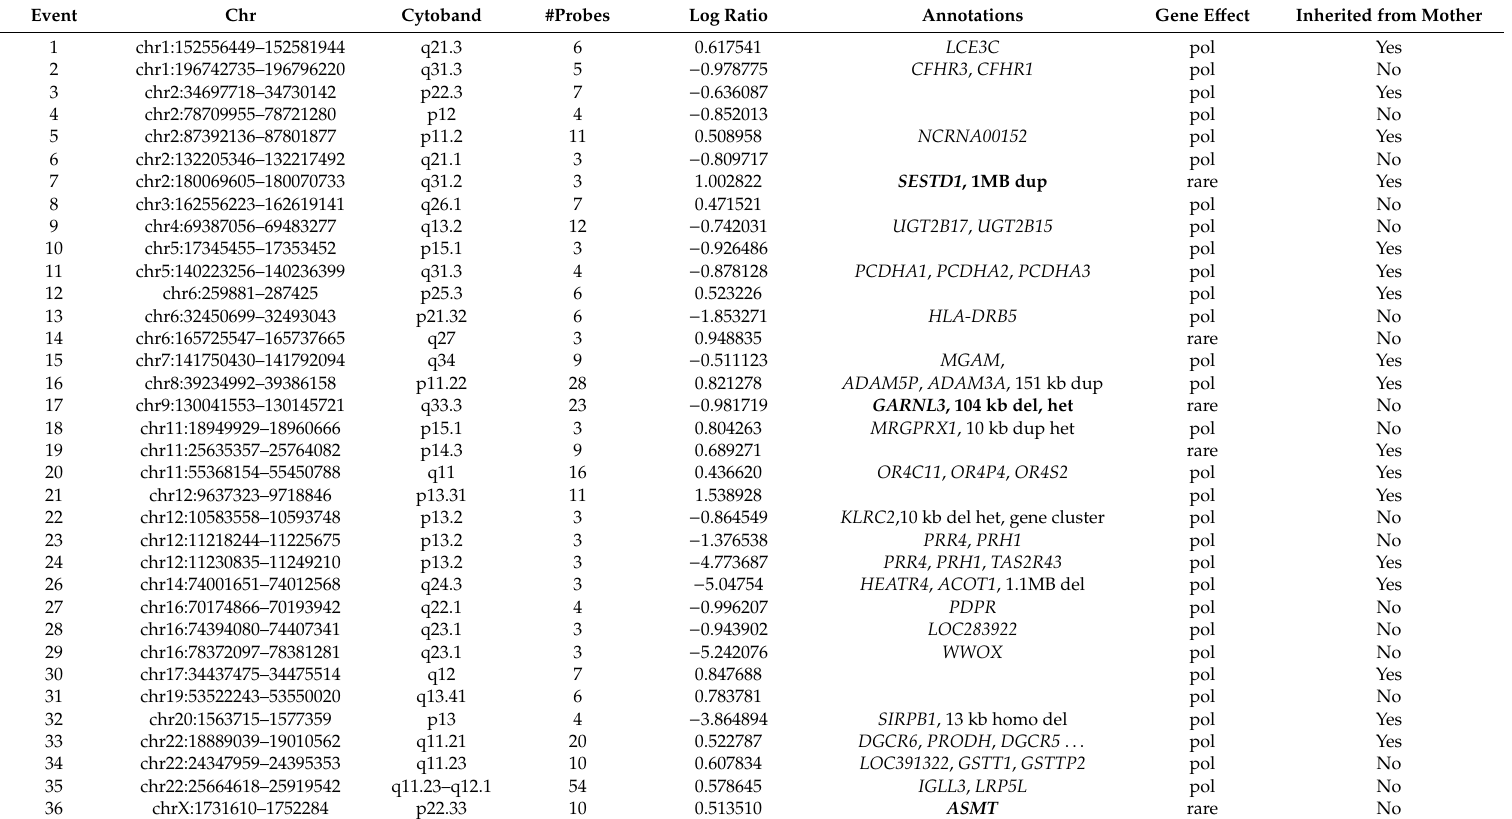
Table 1. The CNV analysis report summary of the aCGH results for the AZ patient. Variants were identified and annotated using Cytogenomics software with the ADM-2 protocol criteria. All variants were then manually reviewed and categorized using the process described in Figure 3. The frequency was either polymorphic, labeled “pol,” or rare, based on the DGV database (The Centre for Applied Genomics). All variants were compared to the mother’s CGH results and variants were identified as maternally inherited (“Yes”) or not